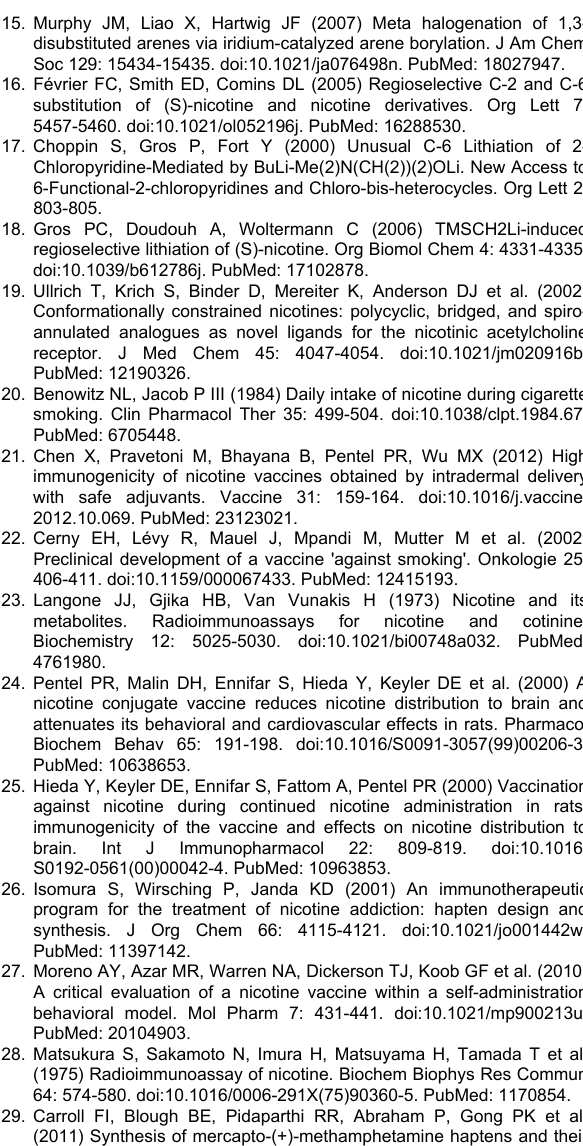
Figure S36. Preparation of Methyl 3-(1'-methyl-5,6- dihydrospiro[cyclopenta[c]pyridine-7,2'-pyrrolidine]-4- yl)propanoate.